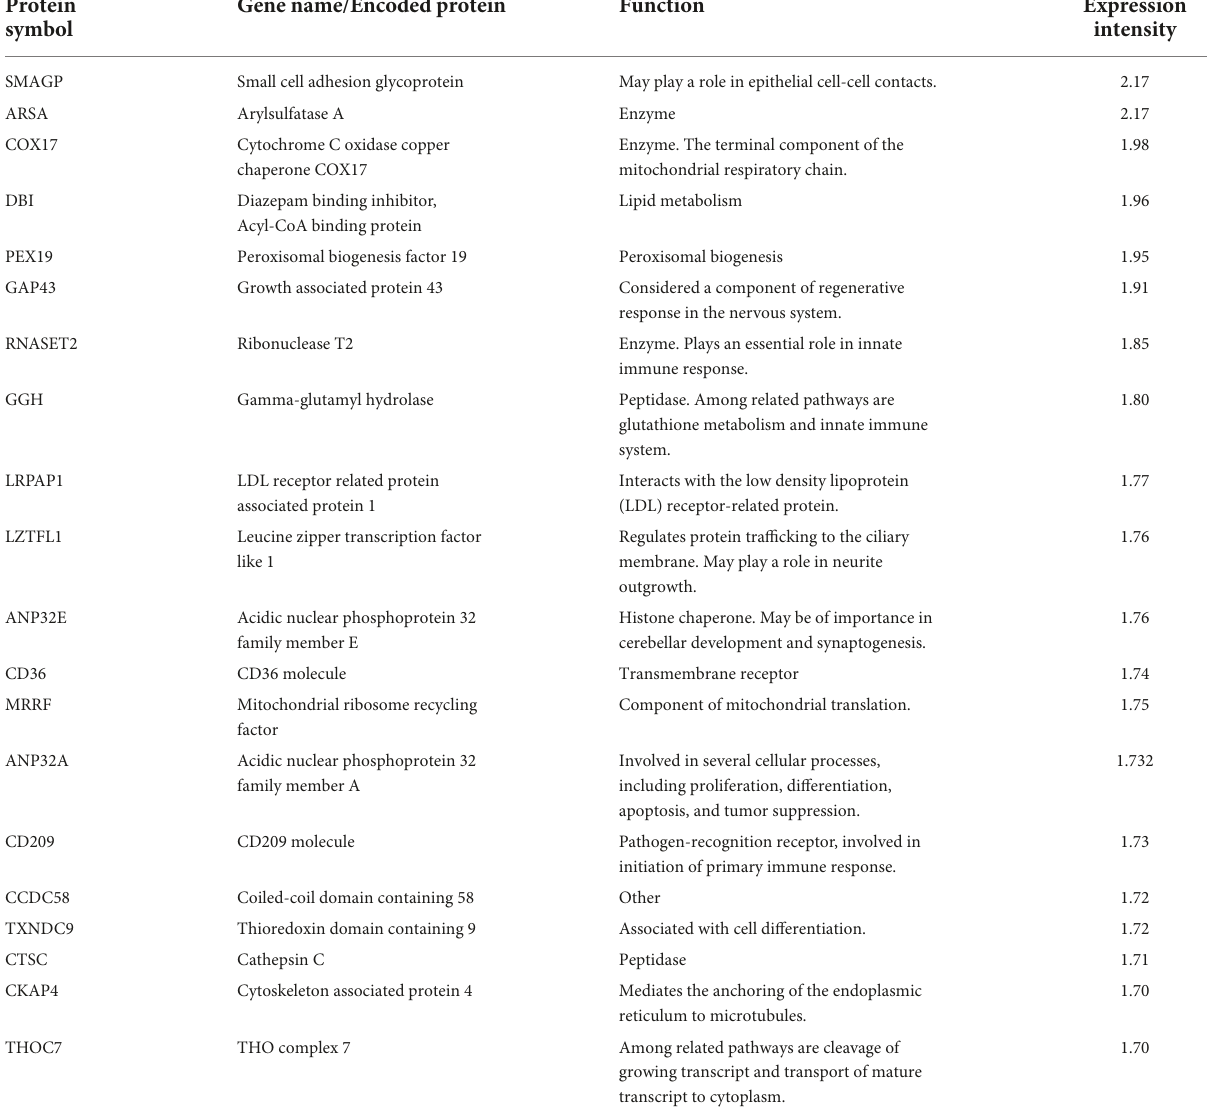
TABLE 3 The 20 most highly expressed proteins in human term healthy